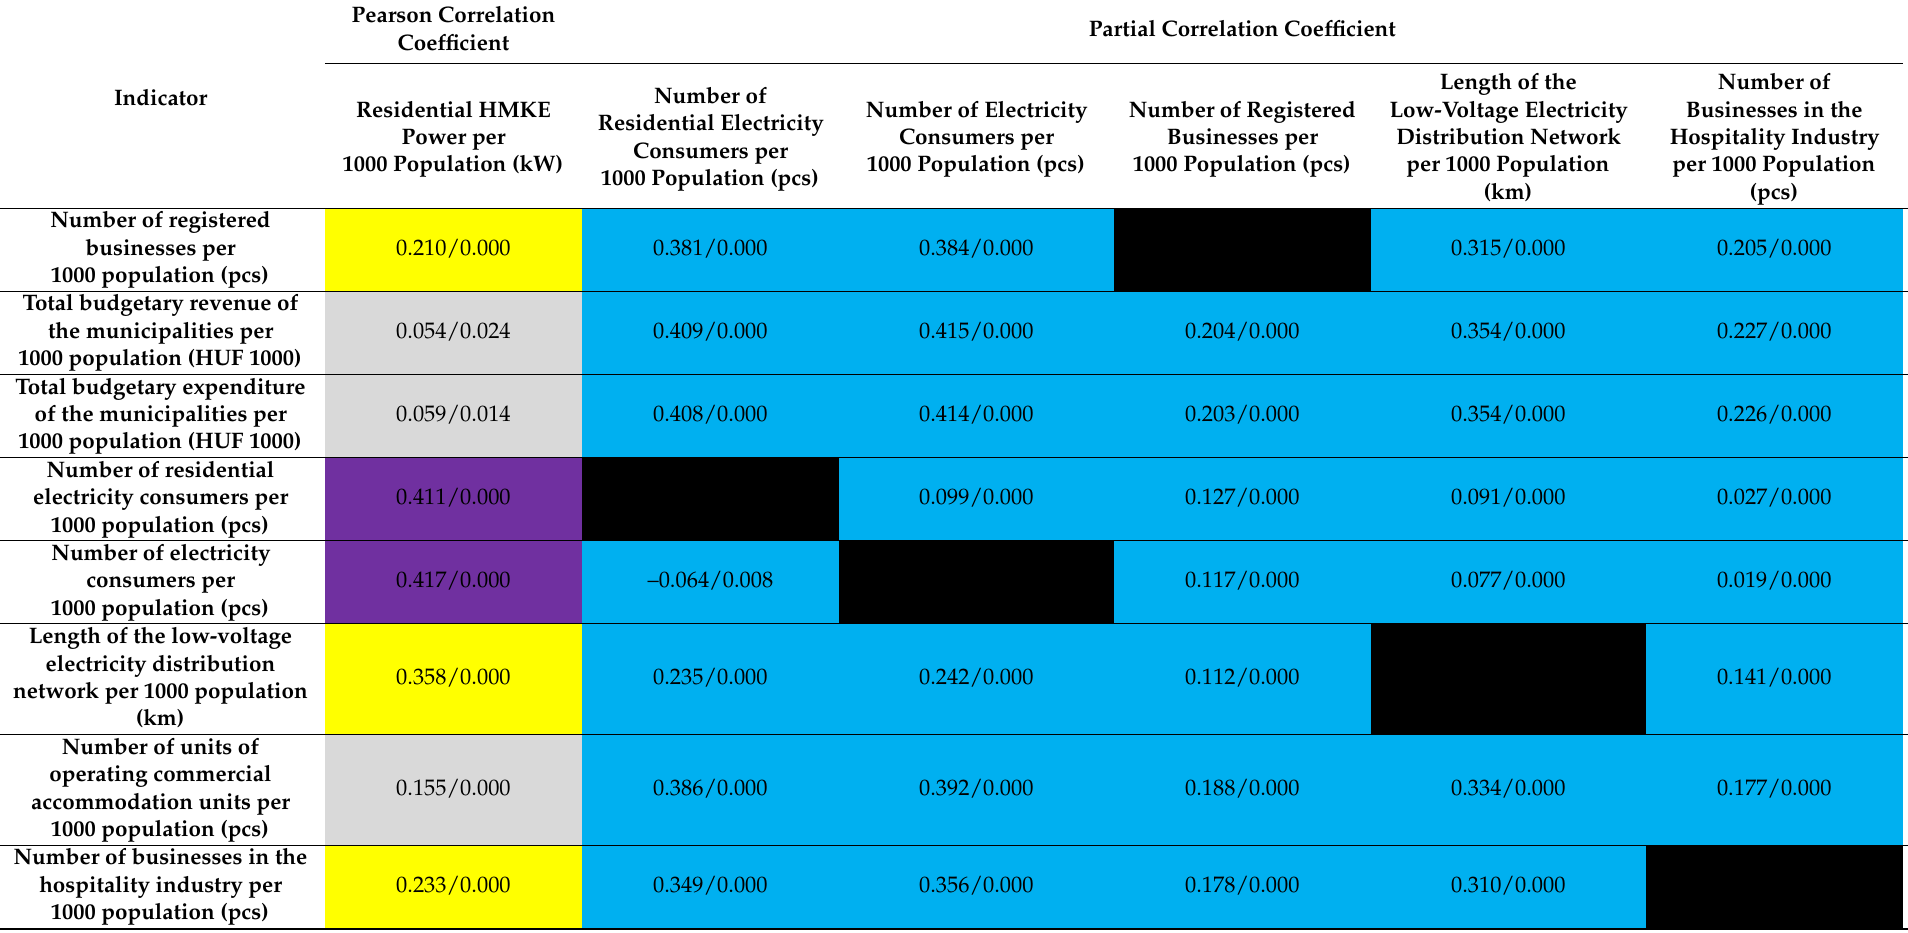
Table A6. The strengths of the relationships between the power of the residential HMKEs per 1000 population and the settlement indicators 1 ( 1 Pearson correlation coefficient/ p -value; if p < 0.05, then there is a significant verified relationship between the two variables) (In the case of the Pearson correlation coefficients in the table grey background indicates weak correlations, yellow means weak moderate, and purple moderately close ones. In the case of the partial correlation the blue background signals partial explanation (the controlled variable explains the relationship between variables i and j only partially), while the black one shows irrelevant